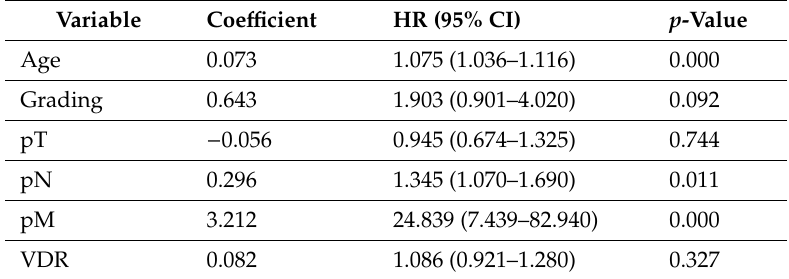
Figure 4. Kaplan–Meier survival analysis in VDR-negative and -positive patients. (a) OS of patients with unifocal BC in years. ( b ) DFS of patients with unifocal BC in years. ( c ) OS of patients with multifocal BC in years. ( d ) DFS of patients with multifocal BC in years. The VDR is defined to be positive (green curve) with an Immunoreactive score (IRS) ≤ 25. Table 7. Multivariate Cox regression analysis of unifocal BC patients regarding OS.